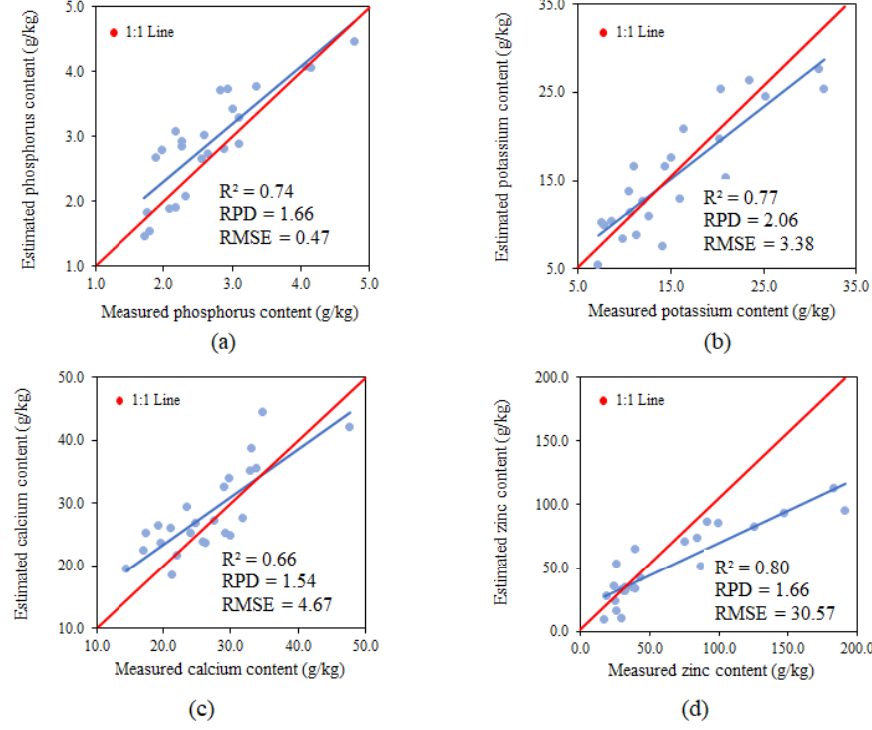
Figure 13. Relationships between the measured and estimated P ( a ), K ( b ), Ca ( c ) and Zn ( d ) content using data from all three of the phenological stages (V4, R6 and R9).